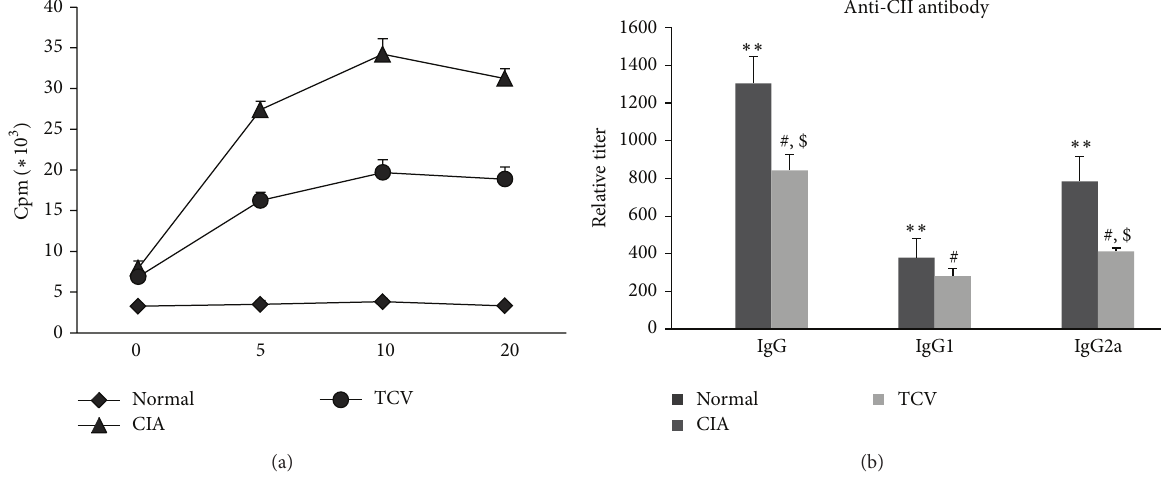
Figure 5: TCV influenced the proliferation of CII-specific cells and levels of CII antibodies in CIA mice. The three groups of mice were sacrificed at the peak of the disease. Spleen MNCs were prepared and incubated (5 × 10 5 cells/well) in the absence and presence of heat- inactivated CII (20 𝜇 g/mL) for 48h to 54h. [ 3 H]Thymidine was added during the last 18h of culture. (a) The cpm values were obtained by liquid scintillation counter in the proliferation assay. (b) Heart blood was collected at the peak of disease and the serum was isolated by centrifuge. The levels of IgG, IgG1, and IgG2a were detected by indirect ELISA. Data are represented as means ± SD ( 𝑛 = 10 mice/group). Data were representative of 3 separate experiments with similar results. ∗ 𝑃 < 0.05 , ∗∗ 𝑃 < 0.01 , CIA versus normal group. # 𝑃 < 0.05 , TCV versus normal group. $ 𝑃 < 0.05 , TCV versus CIA